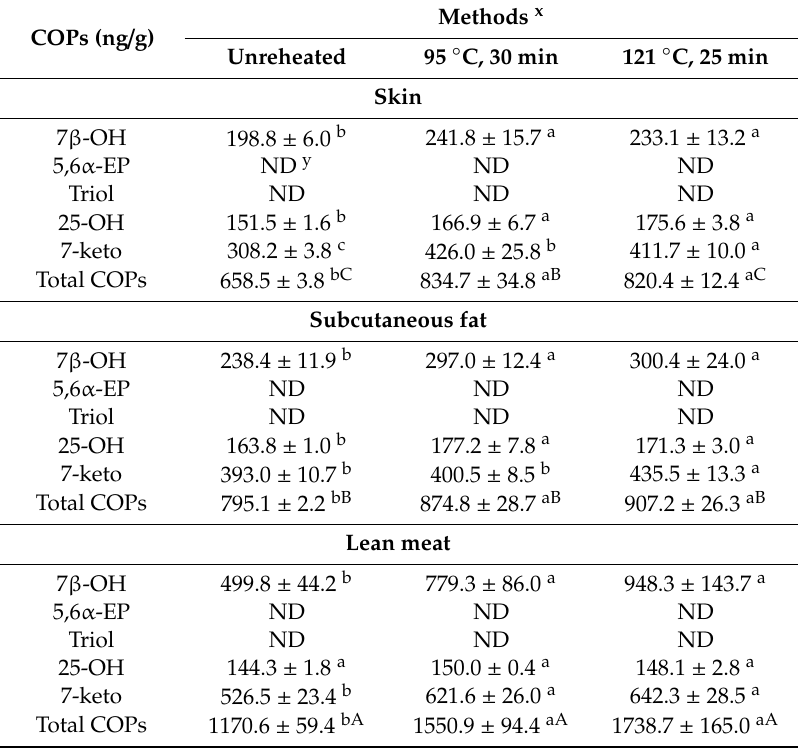
Table 3. E ff ects of reheating on the formation of COPs in the marinated pig hock skin, subcutaneous fat, and lean